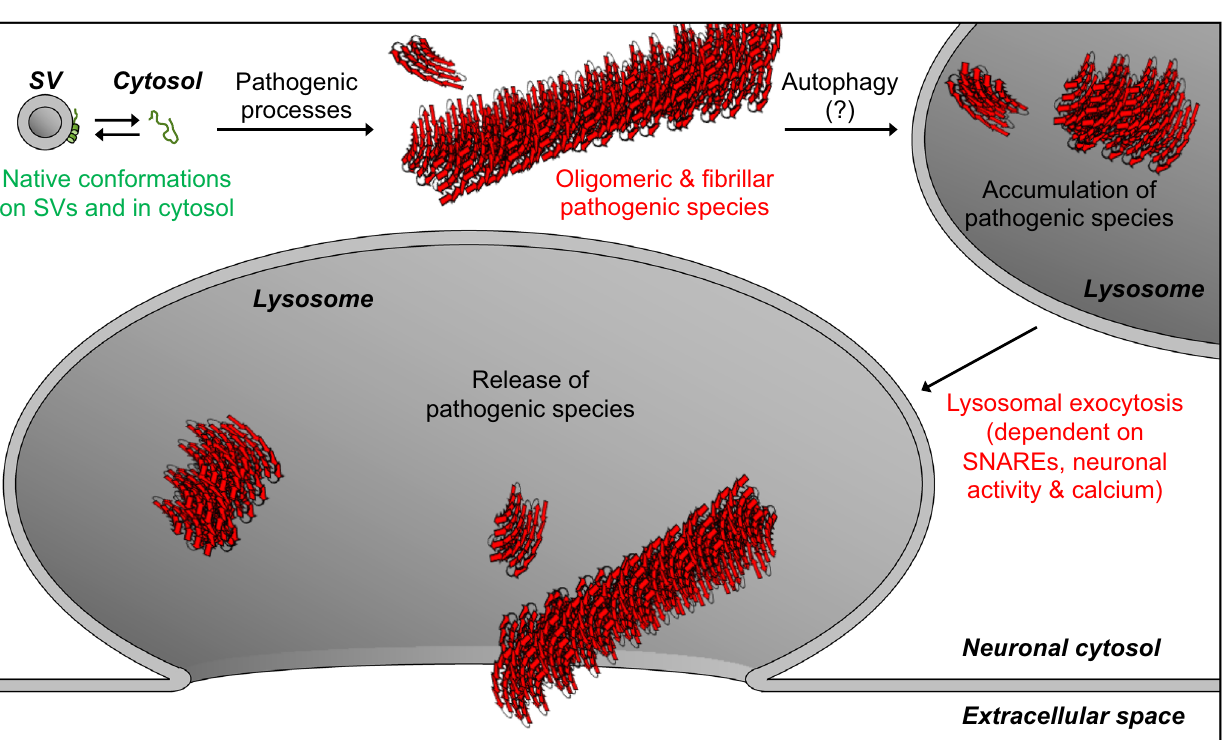
Fig.7|Modelofour fi ndings:Lysosomalexocytosisreleasespathogenic α Synspeciesfromneurons. Native α Synisexpressedasanativelyunstructuredmonomerin the cytosol, in equilibrium with an α -helical conformer upon binding the highly curved synaptic vesicle (SV) membrane. Pathogenic processes oligomerize α Syn into β - sheet-richamyloid-typeaggregatesofvarioussizes.Wedemonstrateherethattheselargerpathogenicspecies,generatedintheneuronalcytosol,accumulateinneuronal lysosomes over time, possibly due to their high structural and metabolic stability. SNARE-dependent lysosomal exocytosis releases these non-membrane-enveloped aggregates, and this release is upregulated by neuronal activity and cytosolic Ca 2+